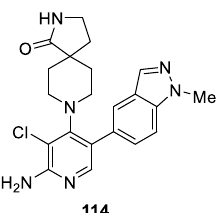
Figure 24. Chemical structure of 1 H -indazole derivative 114.